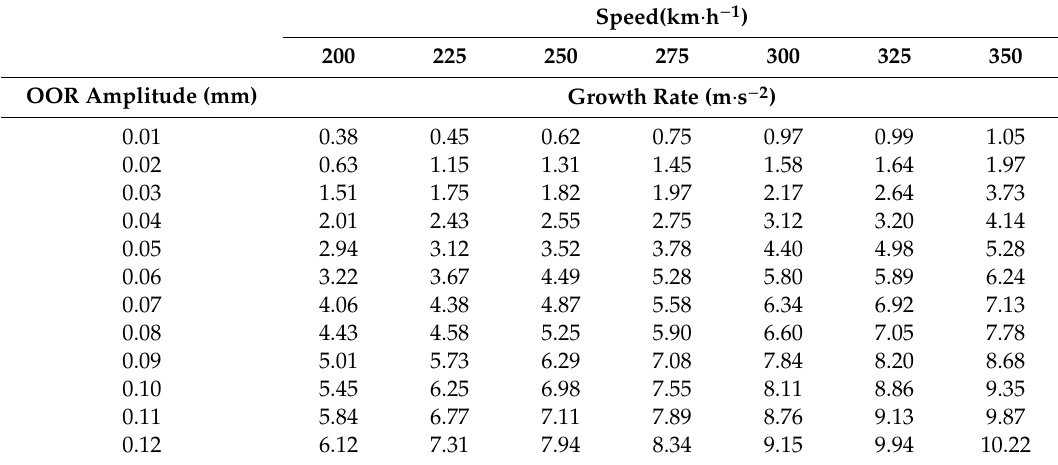
Table 3. Growth per harmonic order of axle-box acceleration due to polygonized wheels, in m · s − 2 · order − 1 .